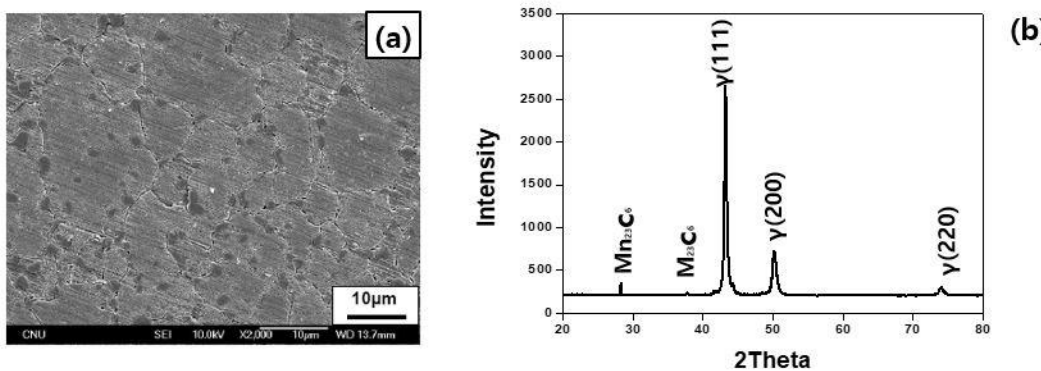
Figure 4. Microstructure ( a ) of groove-rolled rod, exhibiting equi-axed grains, and carbide particles, mostly at grain boundaries and XRD patterns ( b ) exhibiting the peaks from face-centered cubic (FCC) austenite and M 23 C 6 carbides.